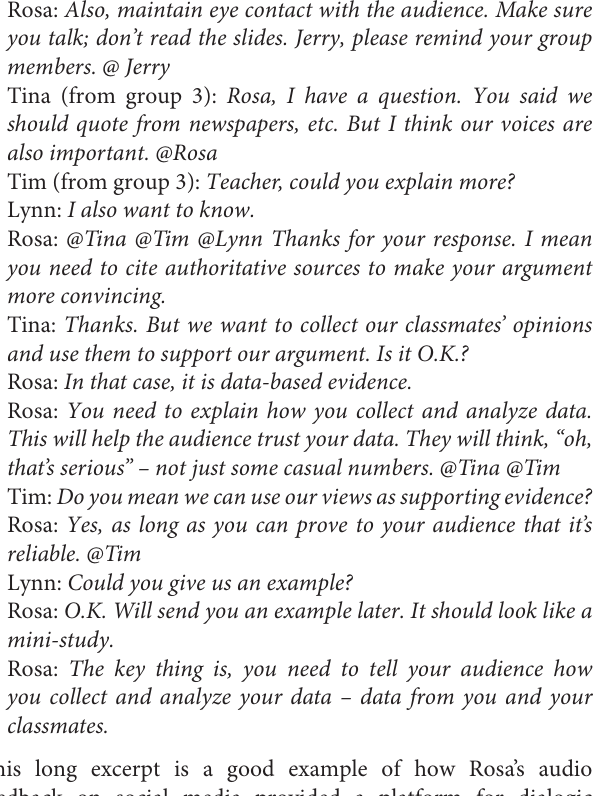
TABLE 3 | Student enactment of audio feedback in oral